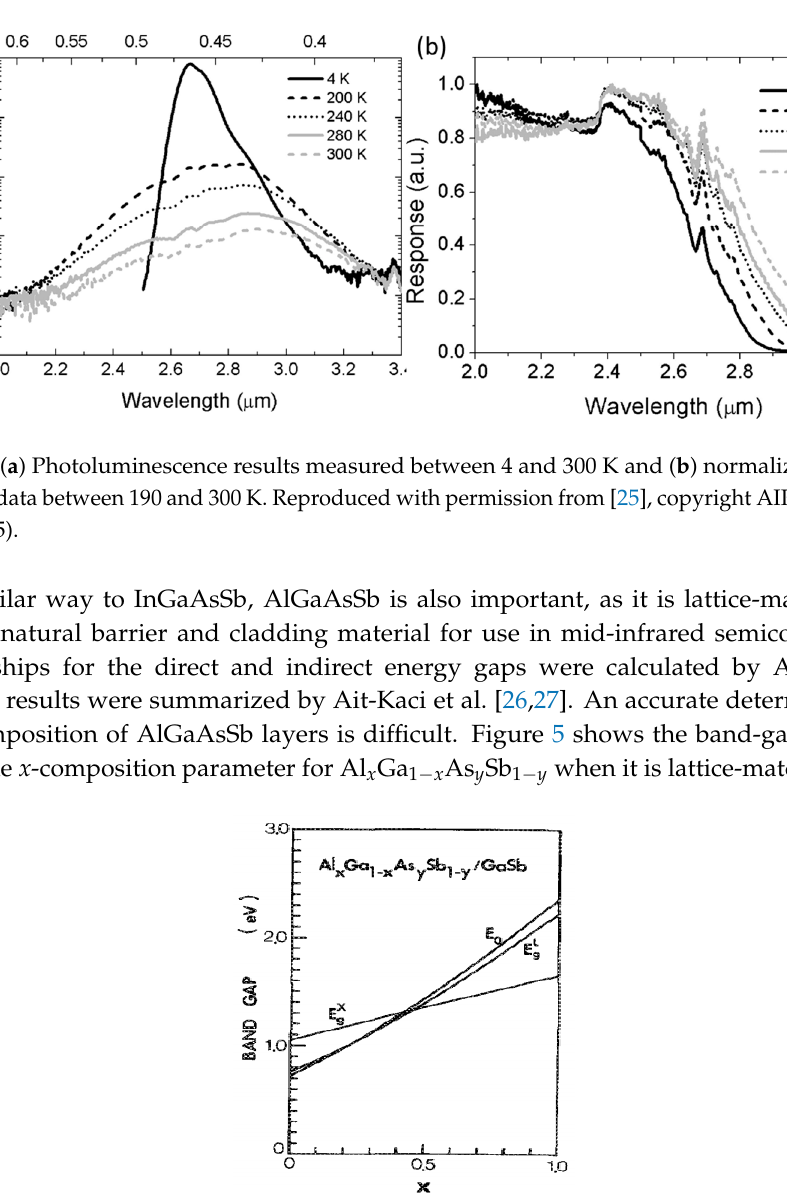
Figure 5. Band-gap energies as a function of the x -composition parameter for Al x Ga 1 − x As y Sb 1 − y when lattice matched to GaSb. Reproduced with permission from [26], copyright AIP Publishing LLC (1987)